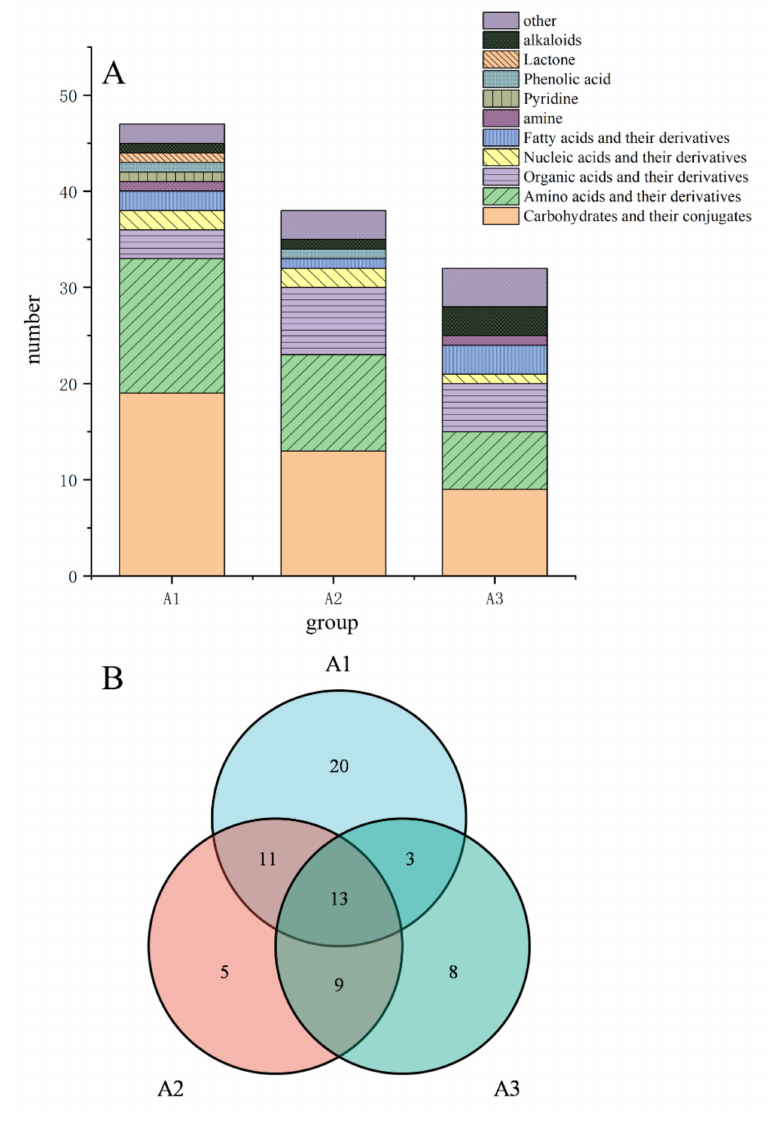
Figure 3. Classification information ( A ) and Venn diagram ( B ) for the differential metabolites in industrially fermented kohlrabi. (A1: Chinese kohlrabies industrially fermented for 0 years and 5 years, A2: Chinese kohlrabies industrially fermented for 0 years and 10 years, A3: Chinese kohlrabies industrially fermented for 5 years and 10